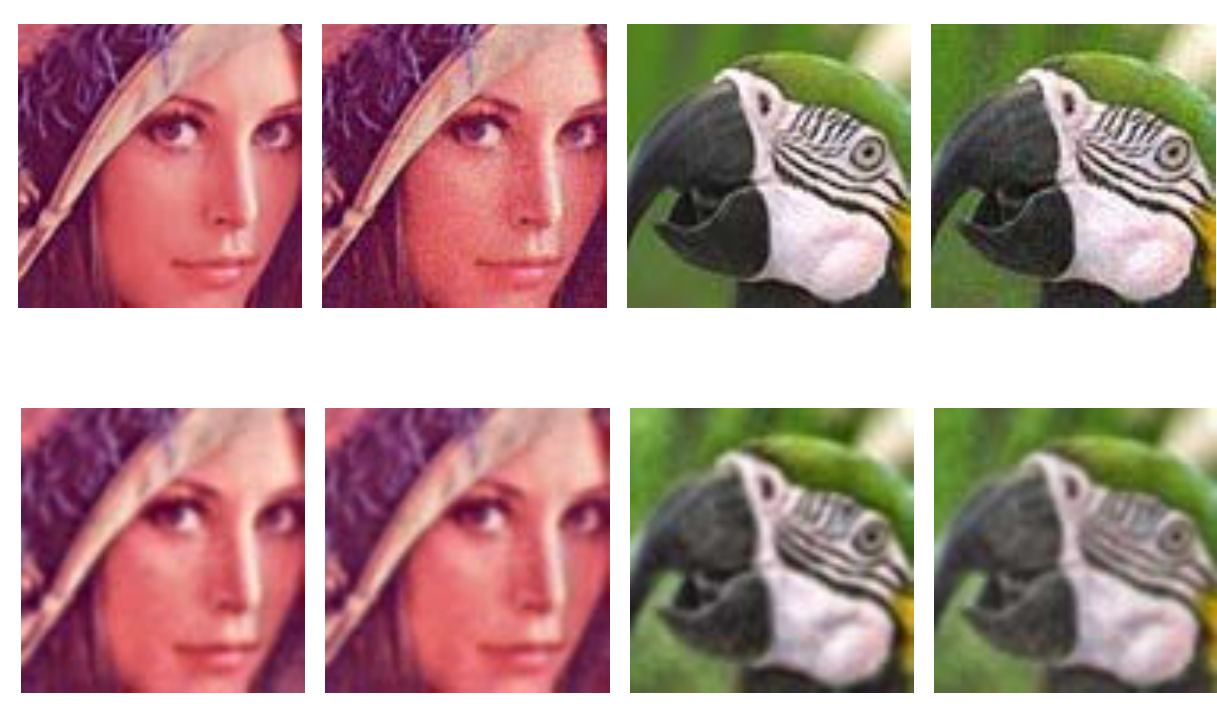
Fig. 9 First row, original images and original images blurred with Gaussian noise with σ = 10. Second row, the result of applying CLAHE and subsequently BF to both images and then the opposite approach, BF and subsequently